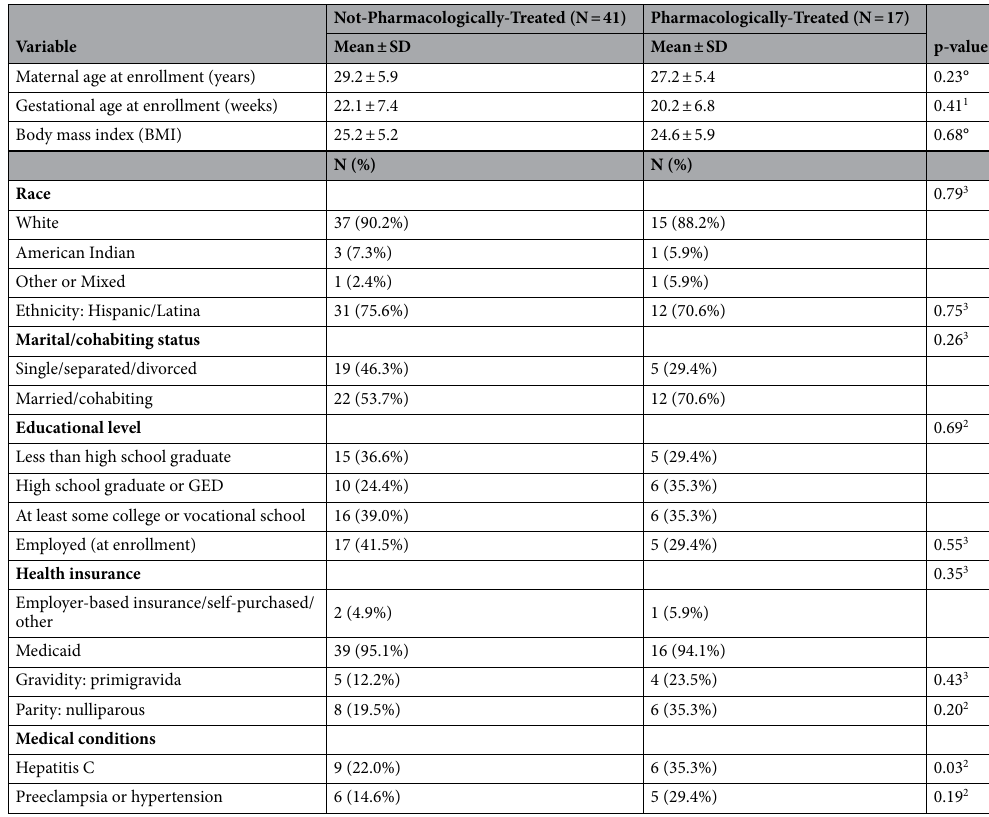
Table 1. Maternal socio-demographic and medical characteristics. GED graduate equivalency degree, SD standard deviation. °Based on pooled variances t-test. 1 Based on Mann–Whitney test. 2 Based on Chi-square test. 3 Based on Fisher’s exact